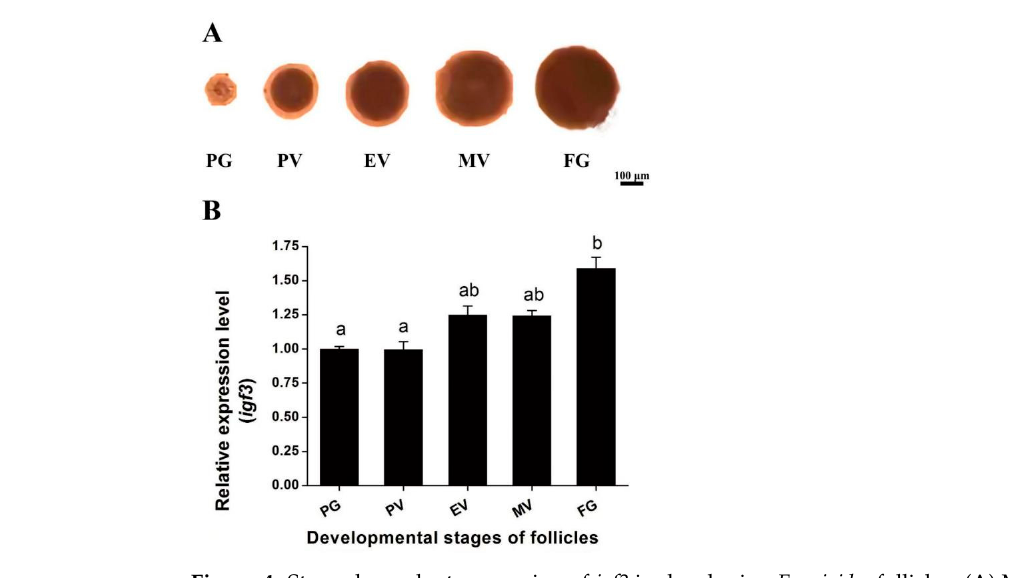
Figure 5. Germinal vesicle breakdown (GVBD) alterations in midvitellogenic (MV) and fully-grown (FG) stages of follicular. Igf3 was added at the ( A ) MV and ( B ) FG stages. ( n = 4). ***, p < 0.001.